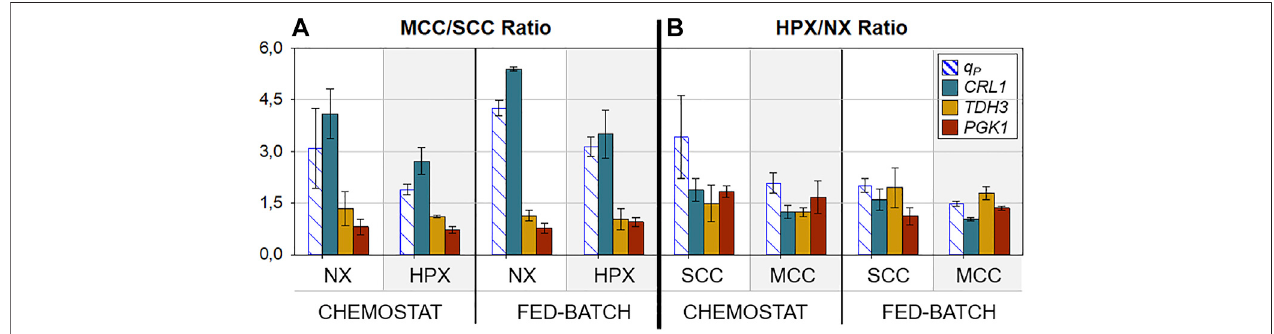
FIGURE 6 | Ratios of q P and relative transcript levels (RTL) of key genes under all conditions tested. (A) Ratio between MCC and SCC for each condition (hypoxic and normoxic). (B) Ratio between hypoxic conditions and normoxic conditions for each clone (SCC and MCC). Error bars calculated by error propagation of the corresponding